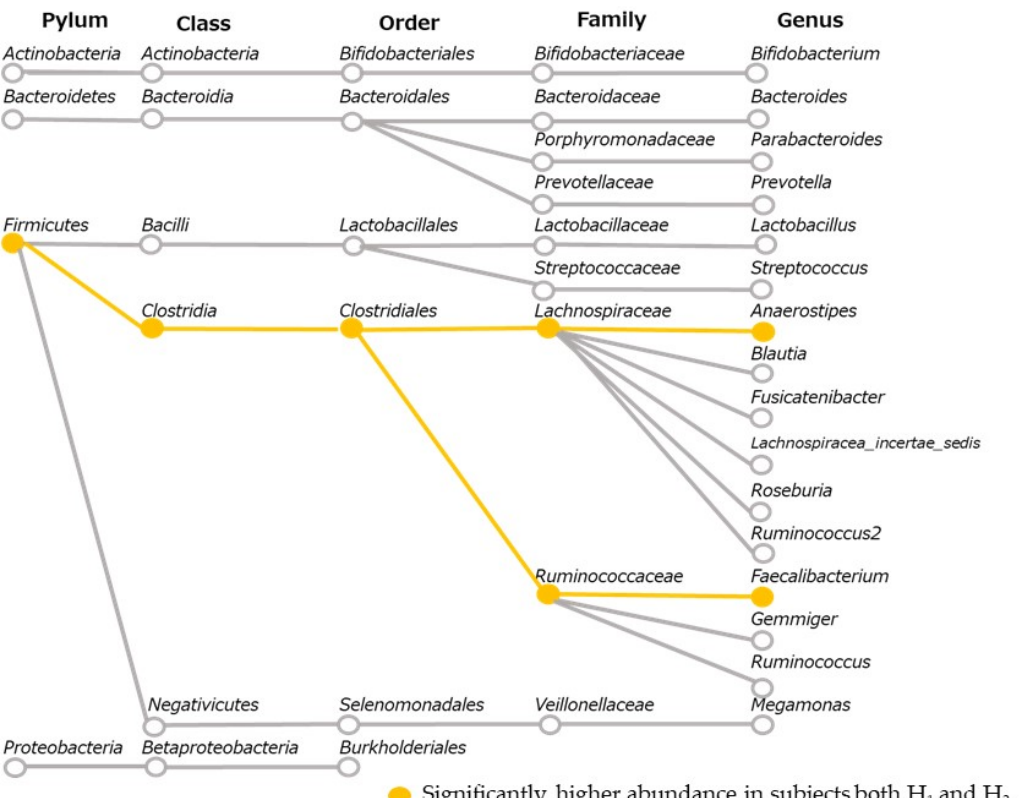
Figure 6. Systemic diagram of bacteria with more than 1% or more relative abundance in this study.